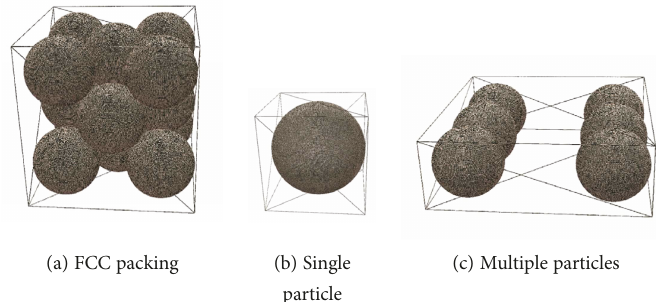
Figure 2: Schematic of the computational